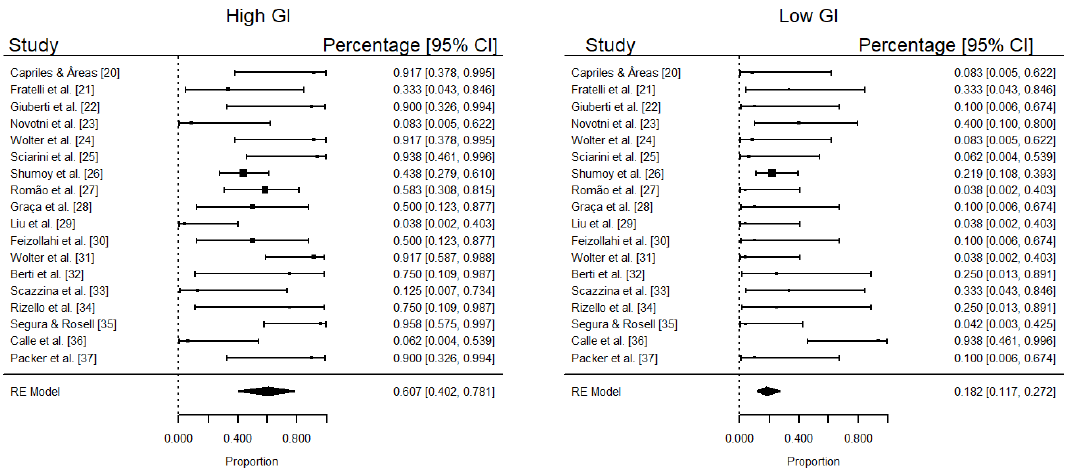
Figure 2. Percentage of bread with high and low glycemic indexes in each study. Percentages and confidence intervals estimated by logit transformation for proportions. Diamonds represent the pooled estimates (95% CI) obtained by Random- Effect Model. Ref [20–37]